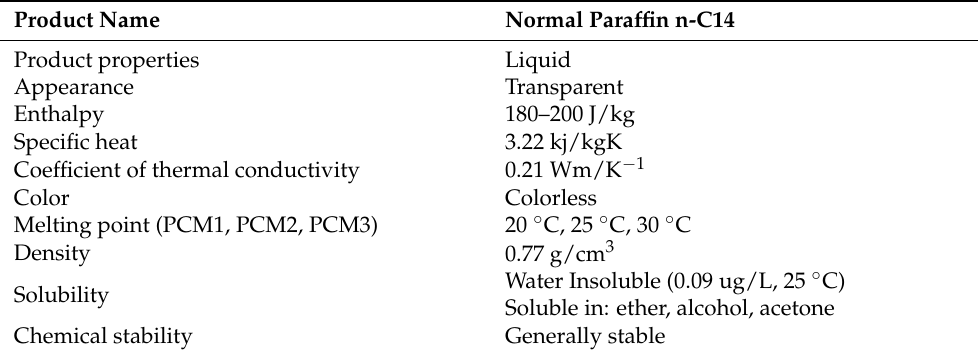
Table 1. Technical specifications of the PCMs used in this